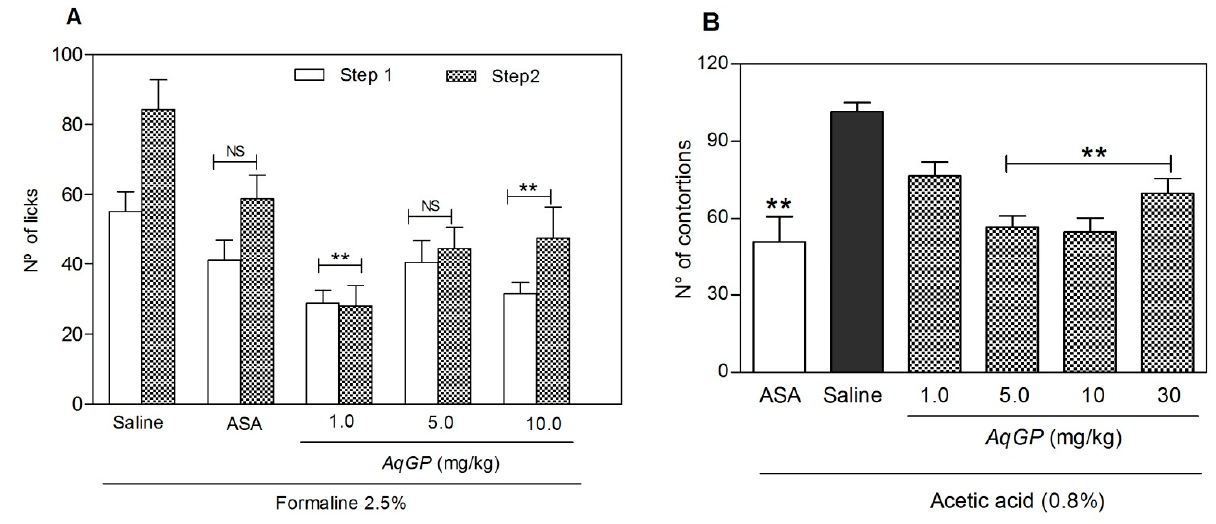
Figure 2. Effect of AqGP pre-treatment on hyperalgesia in mice. All animals were pre-treated with the AqGP extract at concentrations of 1, 5, or 10 mg/kg or acetylsalicylic acid (100 mg/kg) 15 min after the injection of nociceptive stimulant. ( A ) Hyperalgesia was induced by formalin (20 µ L, 2.5%) in the sub-plantar region of the right paw. The number of licks was counted in two phases, phase 1 from 0 to 5 min, and phase 2 from 15 to 30 min. ( B ) Hyperalgesia induced by acetic acid (0.8%, 100 µ L, i.p). The frequency of abdominal contortions was counted for 30 min. The results are expressed as the mean ± SEM of 5 animals. ** p < 0.05 when compared to the untreated control group (ANOVA followed by Bonferroni test). NS: not significant.